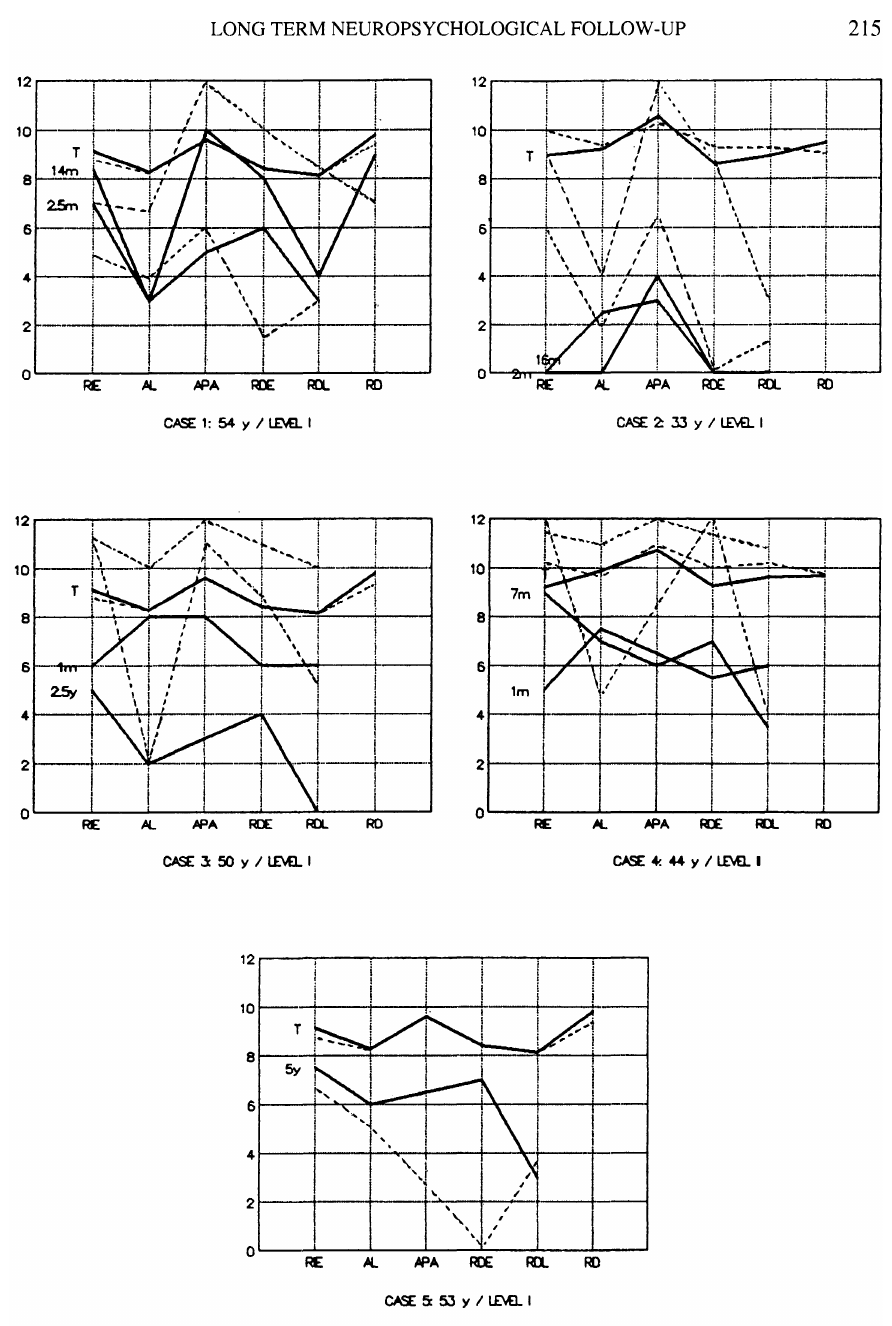
FIG. 3: Results of memory testing with battery 144 (Signoret). T: normal cases matched for age and school level in 3 groups (I: course of studies inferior to 8 years; II: between 8 and 11 years; III: superior to 12 years). Verbal memory; visual memory. RIE, immediate recall of the whole; AL, list learning (series of words or pictures); APA, associative learning of pairs; ROE, long term recall of the whole; ROL, long term recall of the lists; RO, long term recognition. * Curves are associated with the date of testing after onset of encephalitis in days (J), months (m) or years